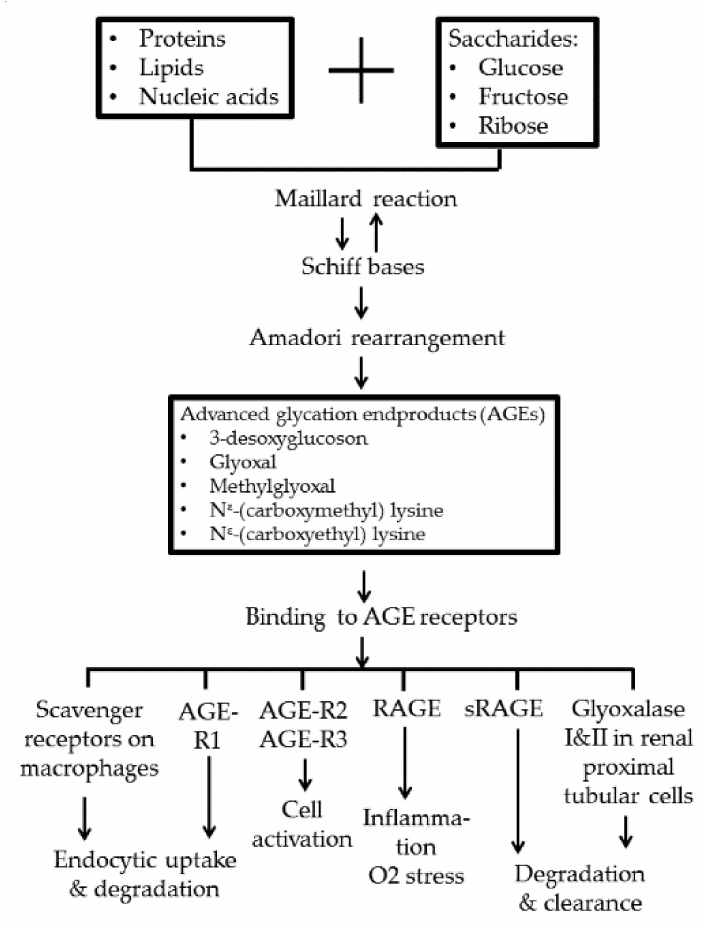
Figure 1. Advanced-glycation end-product (AGE) formation by Maillard reaction and the fates after binding with di ff erent AGE receptors. AGE-R1, R2, and R3: AGE receptors R1, R2, and R3; RAGE: receptor for AGE; sRAGE: soluble-form